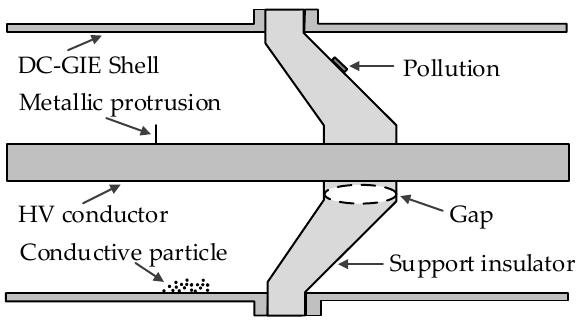
Figure 3. Typical defects in DC-GIE.